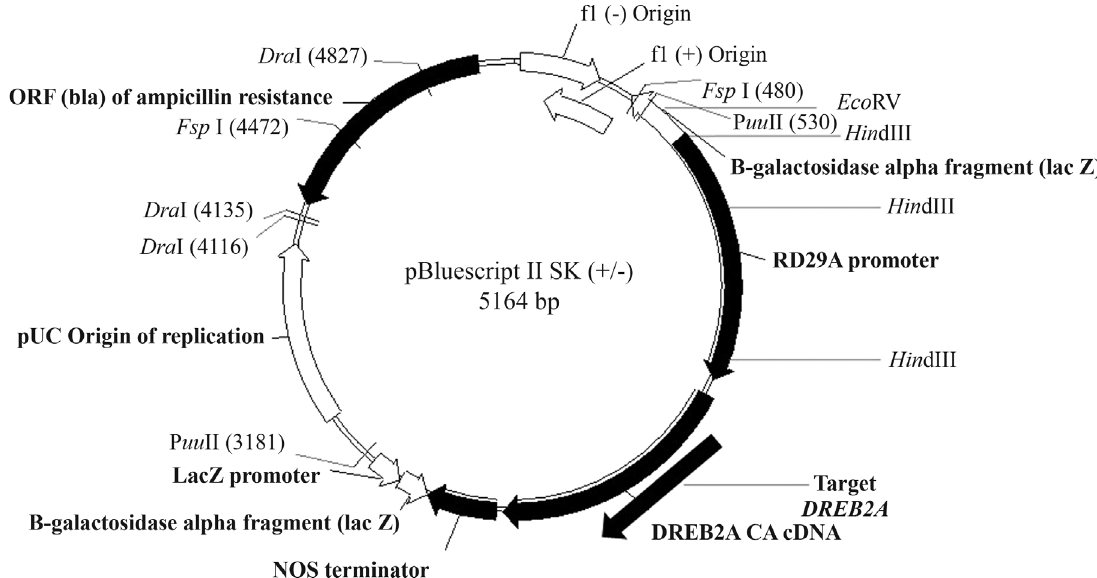
Figure 1 - Plasmid containing the transgene rd29A:AtDREB2A CA and the map of restriction enzymes used in this work. The enzymes used in Southern blotting were Hin dIII and Eco